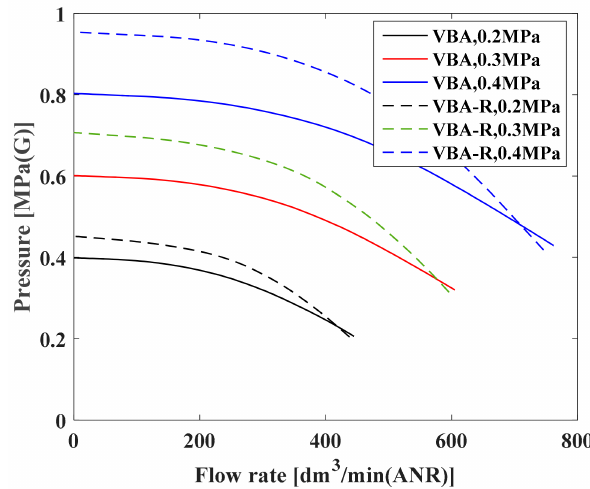
Figure 19. Flow rate characteristics of booster regulator